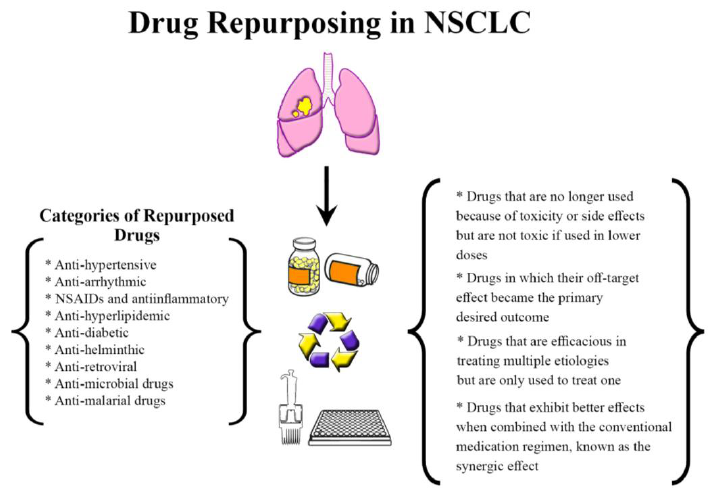
Figure 1. Drug repurposing in NSCLC. Food and Drug Administration (FDA)-approved drugs identified and repurposed to treat patients with NSCLC. Abbreviations: NSAIDs: non-steroidal anti-inflammatory drugs.